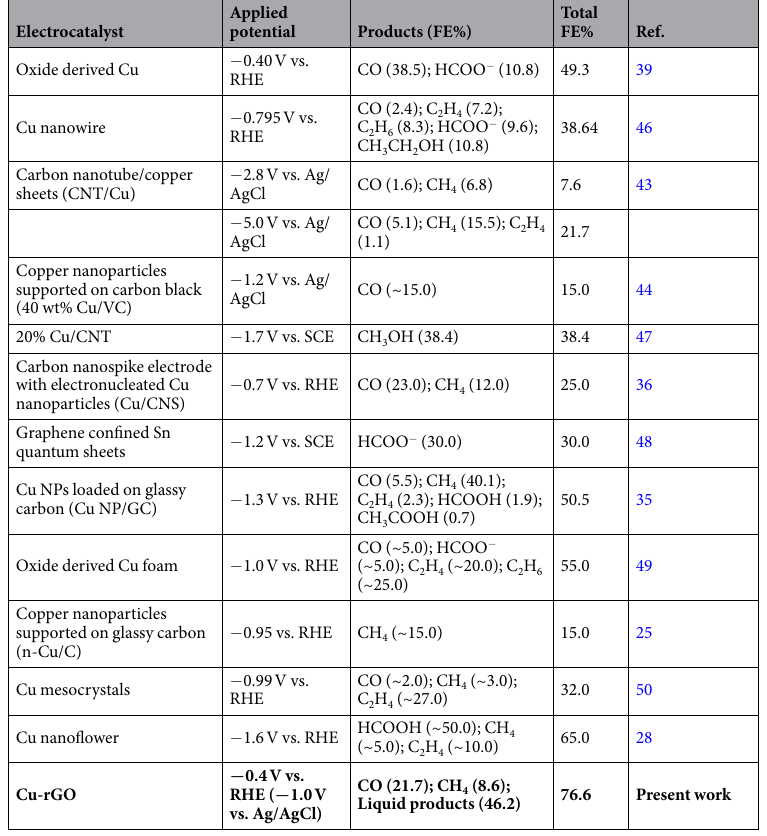
Table 1. Comparison of some promising Cu-based catalysts for the electrochemical reduction of CO 2 recently reported in the literature.